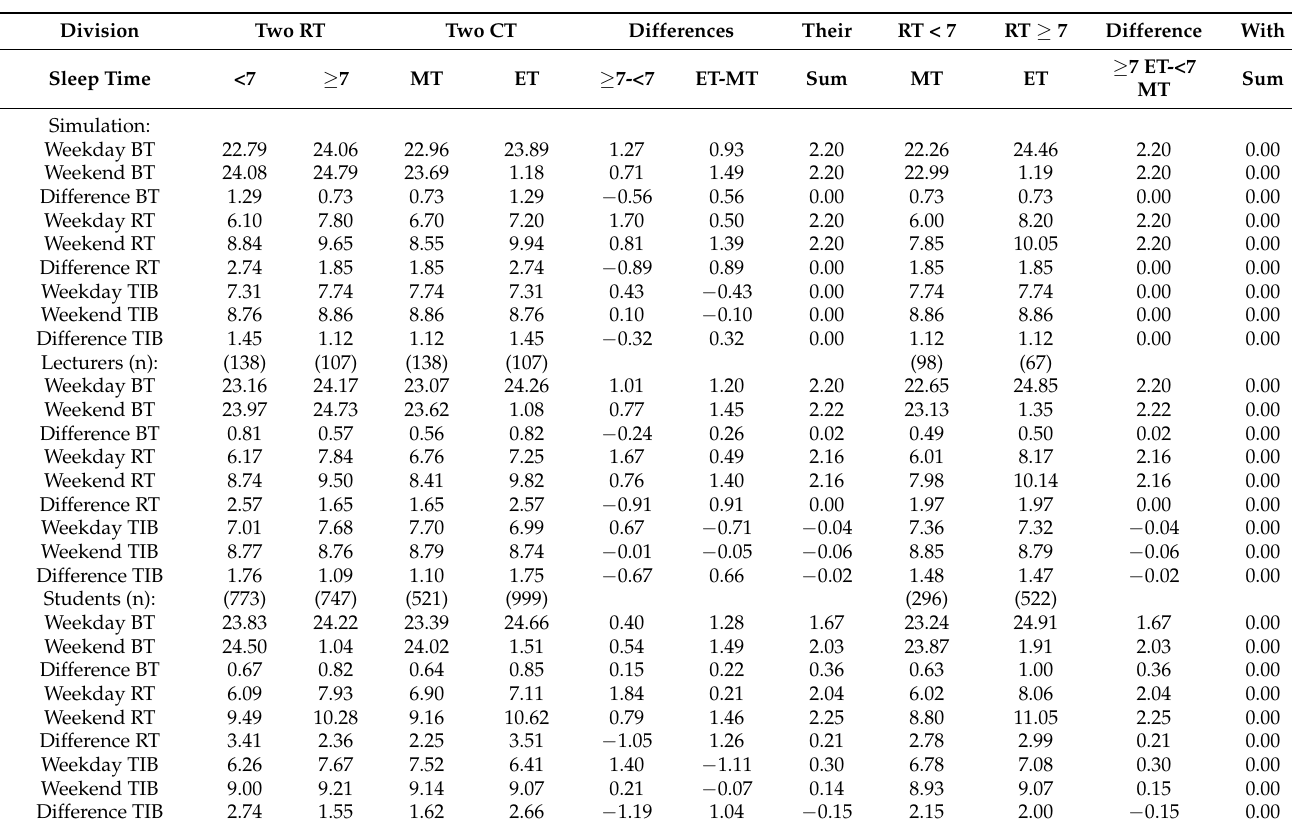
Table 3. Differences in sleep times: early and late